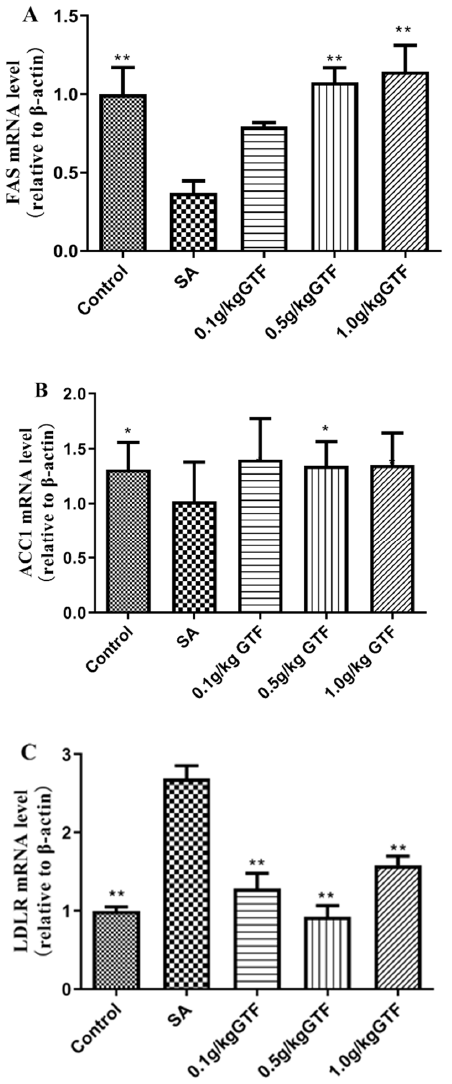
Figure 7. Effects of GTF on the mRNA levels of FAS ( A ), ACC1 ( B ) and LDLR ( C ) in the liver of tilapia. Values are expressed as mean ± SEM ( n = 10). * p < 0.05 and ** p < 0.01 compared with streptococcal injection group.